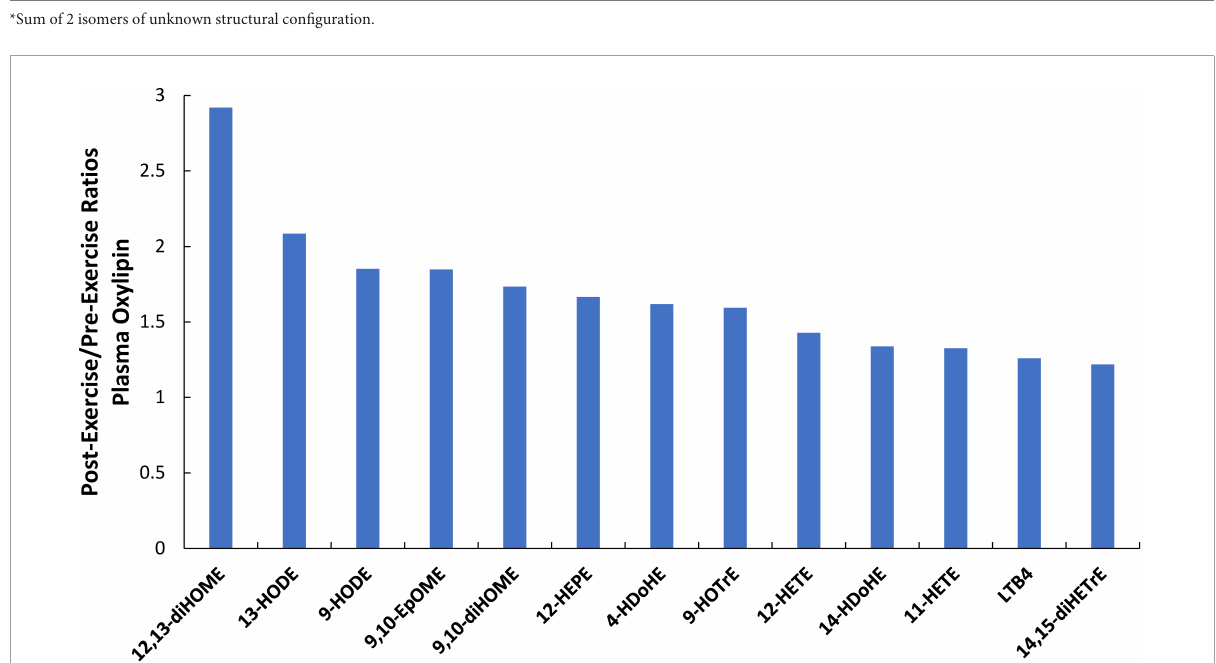
FIGURE3 Immediate-post-exercise increases (post-/pre-exercise ratios) in 13 plasma oxylipins for all subjects combined in response to the 90-min eccentric exercise bout. All q -values < 0.10 after correction for multiple paired t